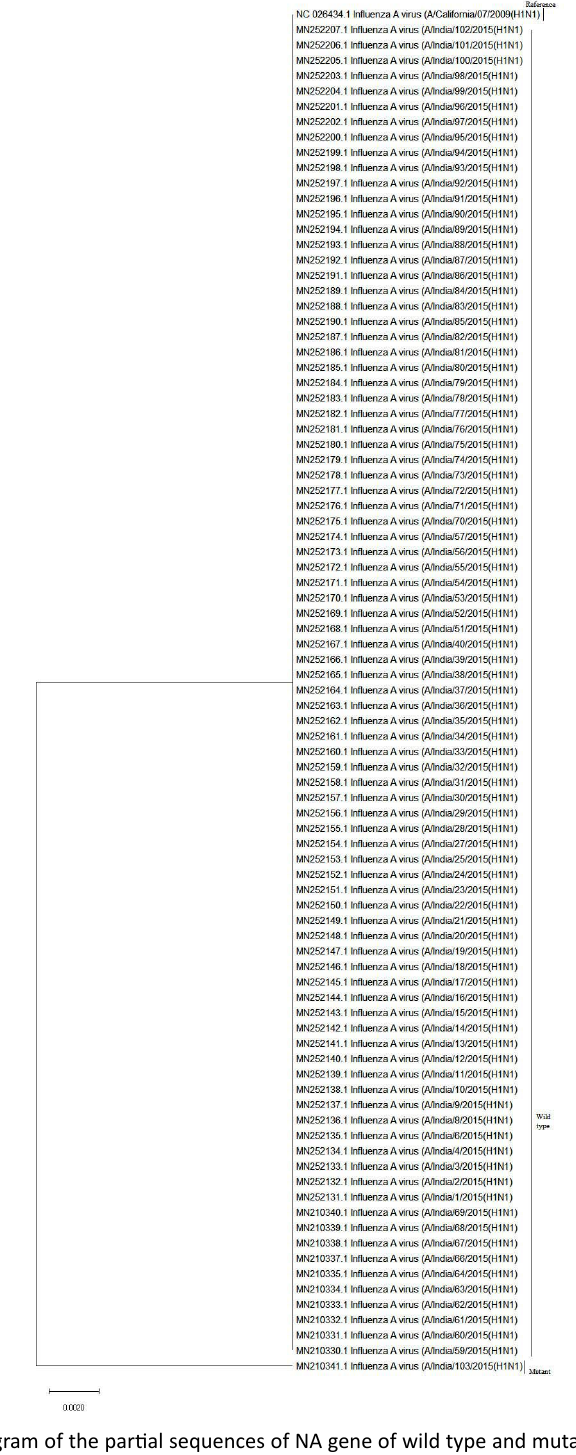
Fig. 2. Sequence dendrogram of the partial sequences of NA gene of wild type and mutant samples aligned with reference to California strain (NCBI Accession. No